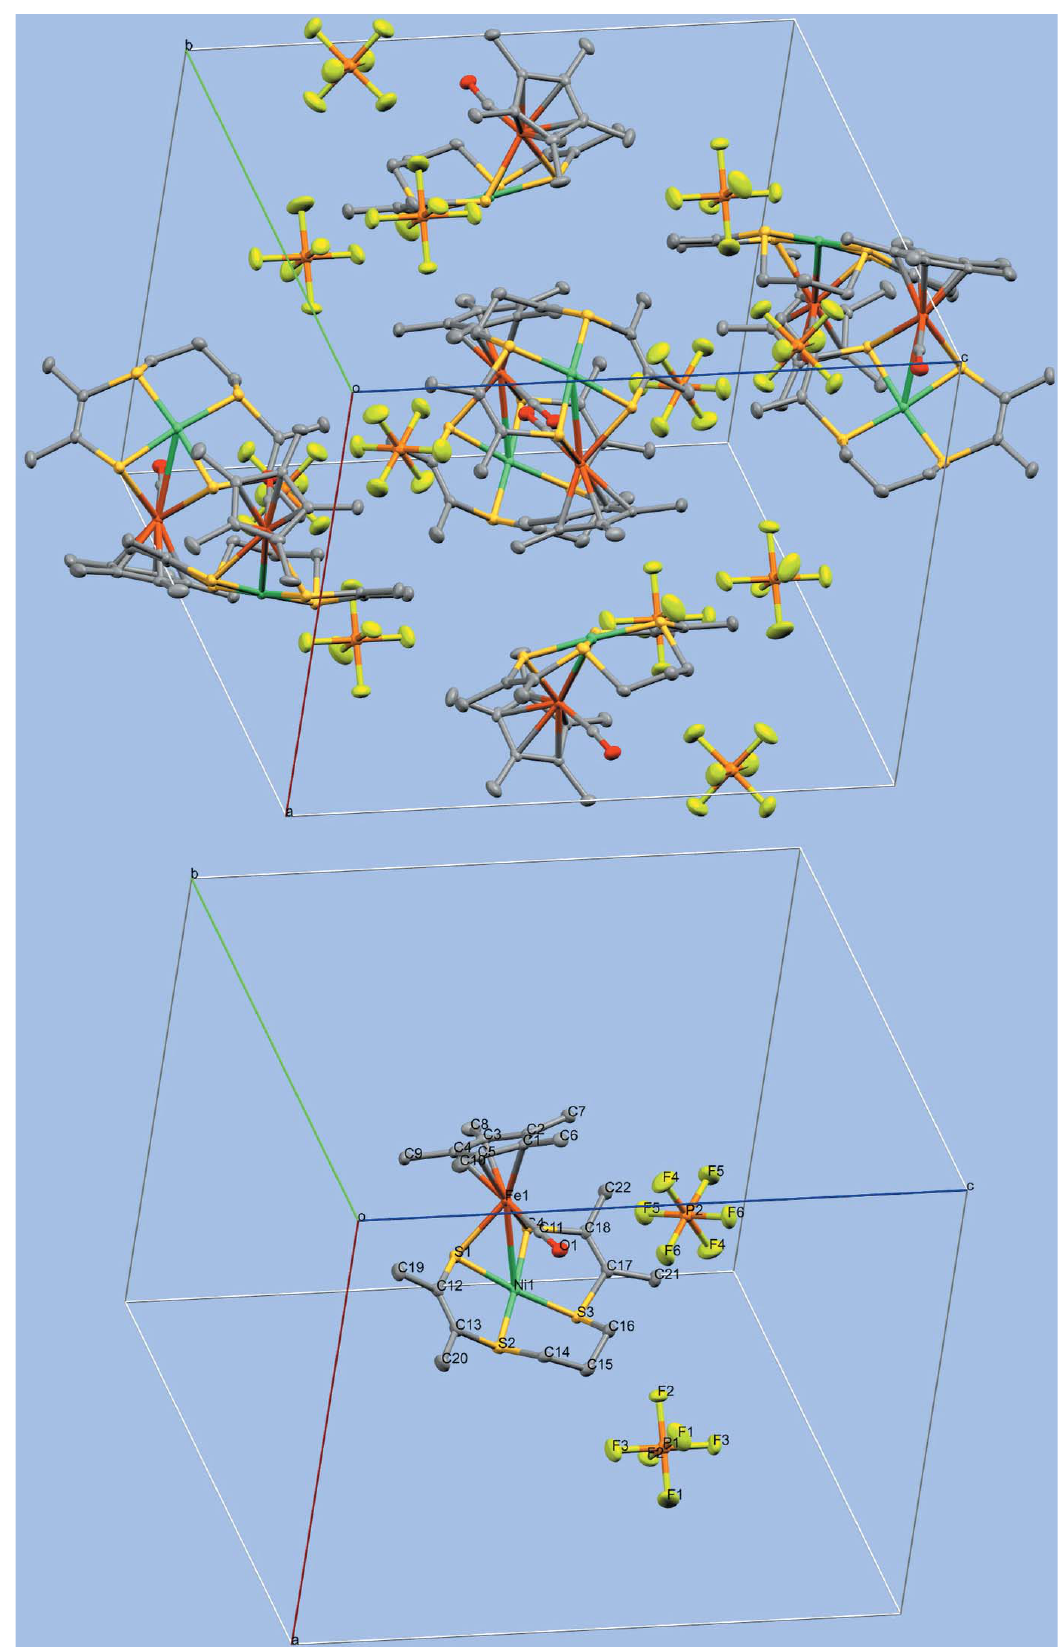
Figure 4 Drawings for packing (top) and labeling (bottom) of all non-H atoms in [Ni( L 0 )FeCp*(CO)][PF 6 ]. Generated using Mercury (Macrae et al. , 2006). For the anion in the bottom part, generic atom labels without symmetry codes have been